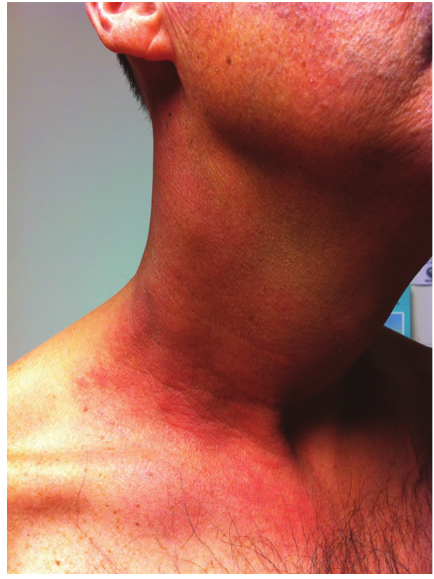
Figure 2: Anterolateral aspect of patient’s right